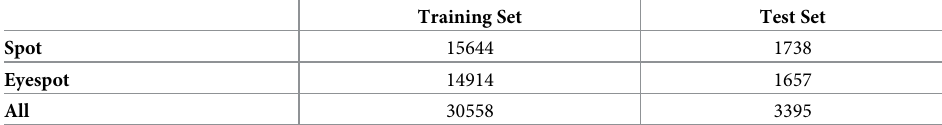
Table 1. Number of pattern elements of each type in the training/validation and test set for dataset1.